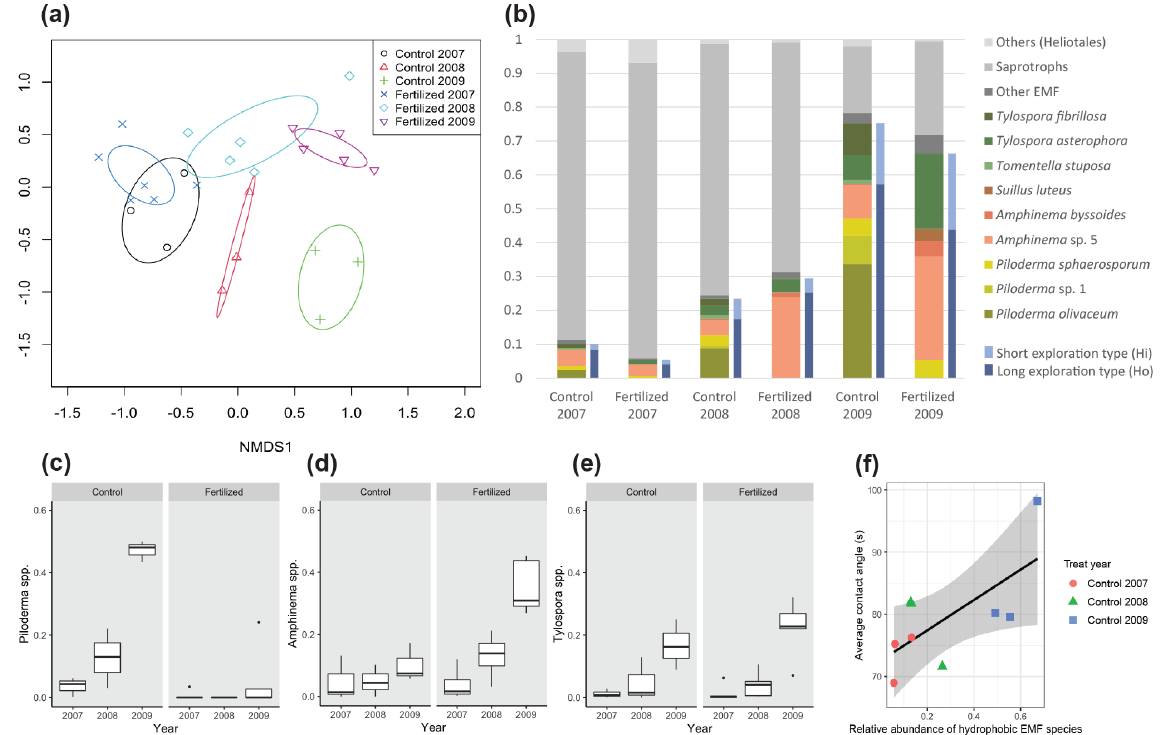
Figure 3. Response of the fungal communities in the mesh bags to the fertilization treatment and incubation time. (a) NMDS ordination analysis of the fungal communities. (b) Relative abundance of the different fungal species and their corresponding mycelium exploration type and hydrophobic (Ho) or hydrophilic (Hi) properties. (c) Relative abundance of the genus Piloderma . (d) Relative abundance of the genus Amphinema . (e) Relative abundance of the genus Tylospora . (f) Correlation between the proportion hydrophobic EMF species and the averaged contact angle (initial CA, CA at 1s and CA at 5s) in the control plots.